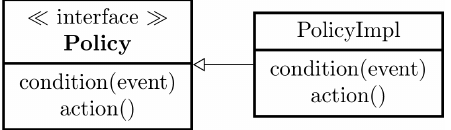
Figure 6. Policy structure diagram.